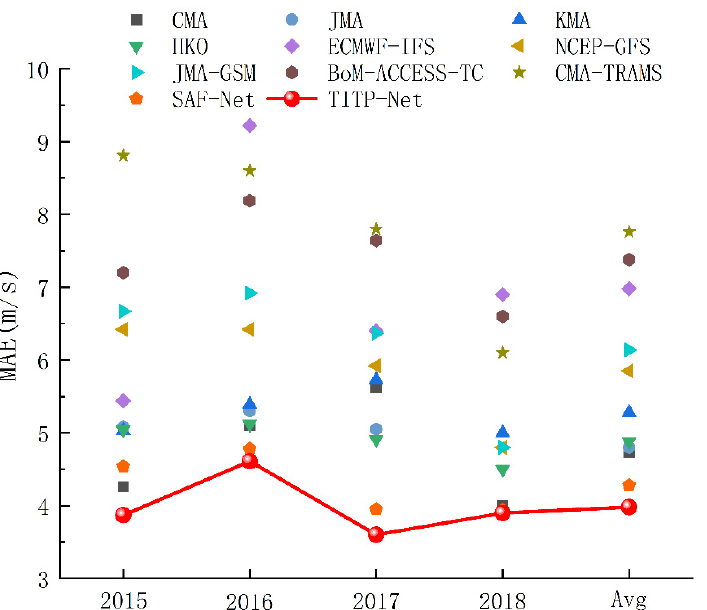
Figure 10. Evaluation of the MAE metrics of typhoon intensity prediction at a lead time of 24 h based on different methods from 2015–2018 and the four-year average error. Each point represents the forecasting MAE for each year and the four-year average error. The red point plot represents the performance of TITP-Net in 24 h prediction.